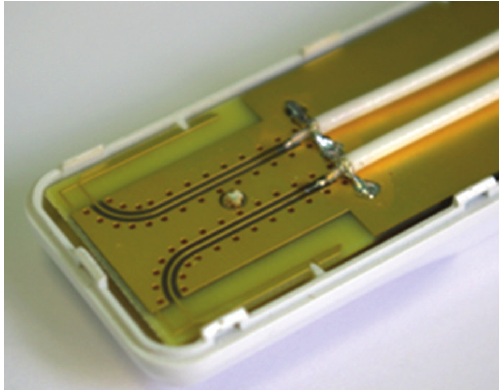
Figure 15: Photo of the fabricated MIMO antenna system #3 with the assembled